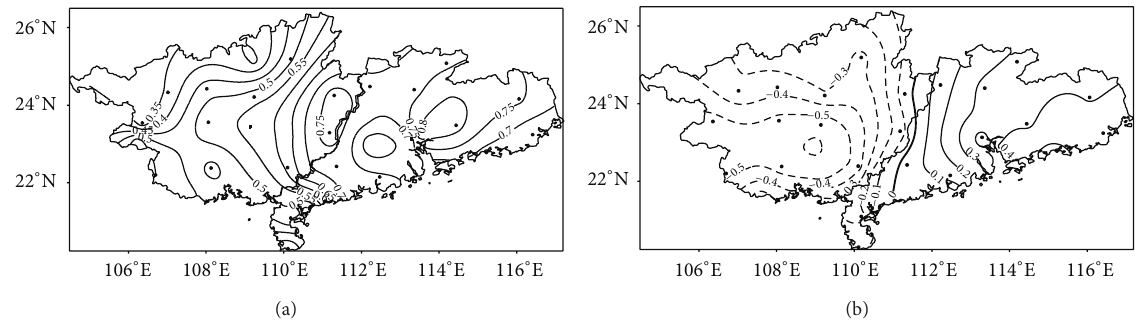
Figure 3: The first (a) and the second (b) eigenvectors of spring precipitation in South